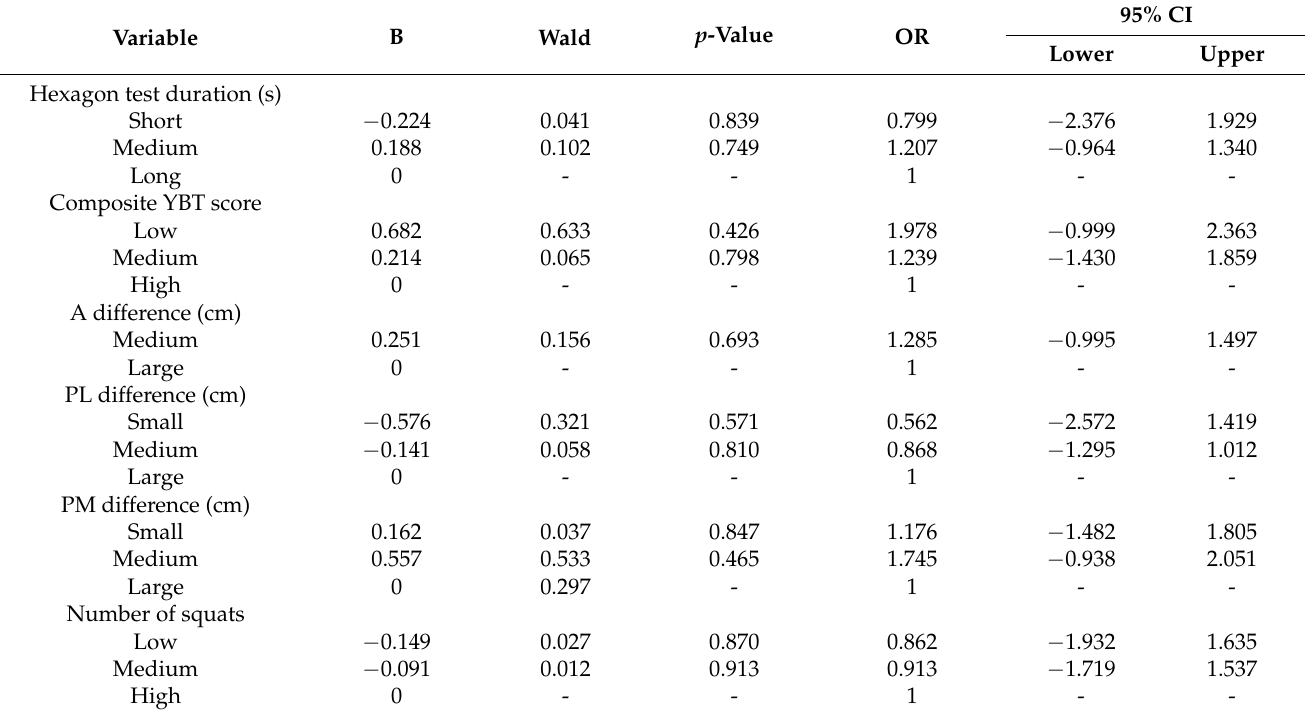
Table 6. Ordinal polytomous logistic regression